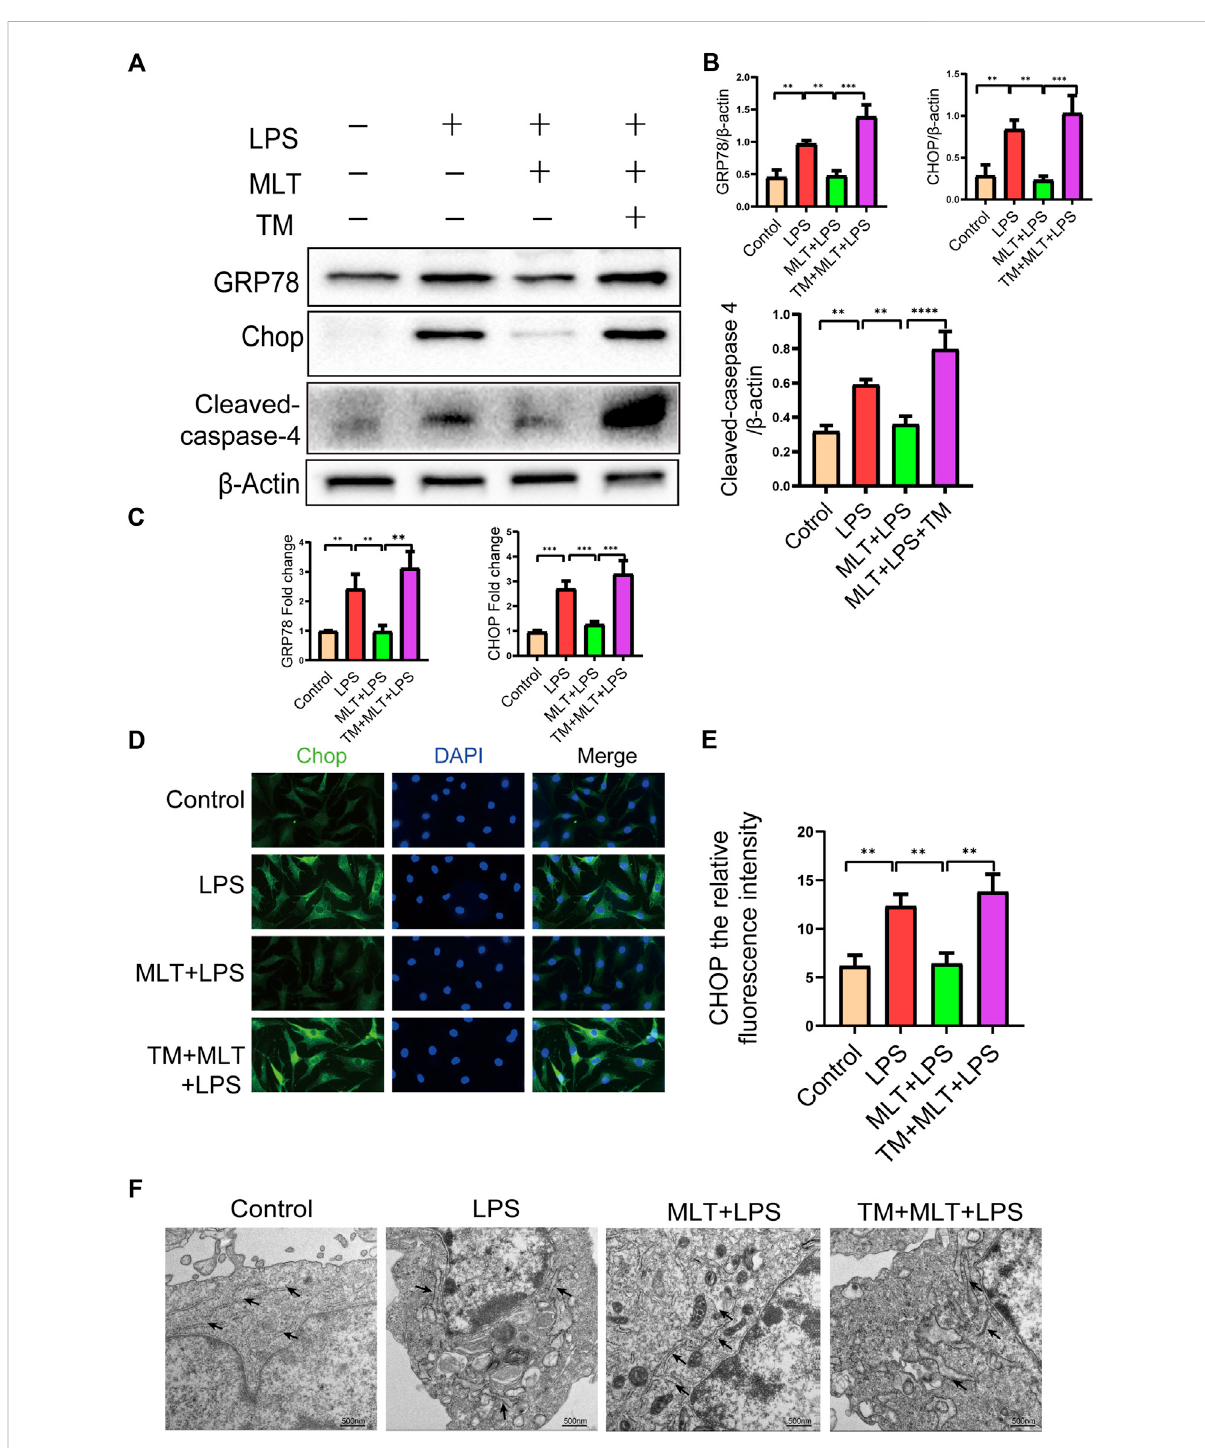
FIGURE 3 Melatonin inhibited in fl ammation – induced endoplasmic reticulum stress in human chondrocytes. (A,B) Western blot analysis Protein expression levels of GRP78, CHOP and cleaved caspas-4 were determined by western blotting. (C) The messenger RNA expression levels of glucose – regulated protein 78 (GRP78) and C/EBP homologous protein (CHOP) were checked by real – time polymerase chain reaction analysis in each group. (D,E) CHOP immuno fl uorescence staining. Obvious increasingly bright green spots indicate elevated CHOP expression (bar, 20 μ m). (F) The effect of altered endoplasmic reticulum morphology after treatment was observed with transmission electron microscopy (bar, 500 nm)(blackarrowsrefertotheendoplasmicreticulum).Theexperimentwasrepeatedthreetimesindependently.Allvaluesareshownasmean± standard deviation. ** p < 0.01, *** p < 0.001, **** p < 0.0001. Abbreviations: LPS, lipopolysaccharide; ns, not signi fi cant; MLT, melatonin; TM,